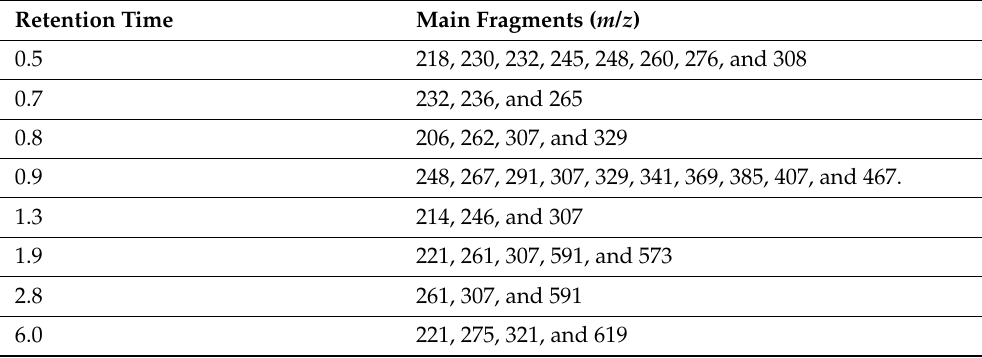
Table 3. Retention time and fragmentation patterns of ARTS reaction products in 20 mM ammonium acetate: